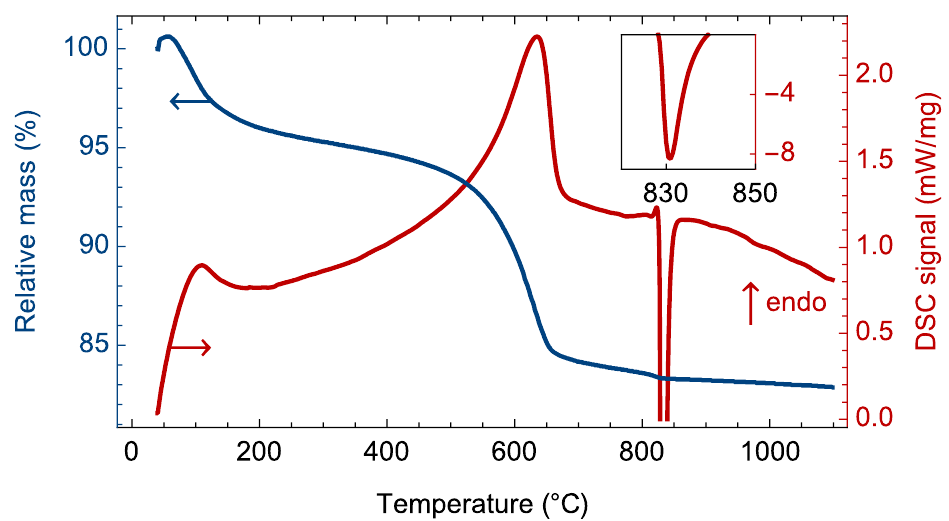
Figure 2. DSC-TG curves of the hydrothermal treatment product. The inset shows the peak of the sharp exothermic effect of magnesium silicate crystallization.